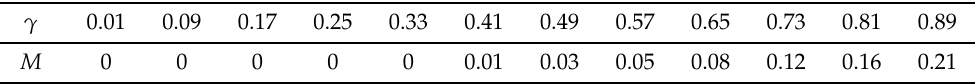
Table 7. Values of the medial correlation of the SGCC copula for θ = ( γ ,1/ γ ,1/ γ ) and several values of γ , belonging to Configuration 1.